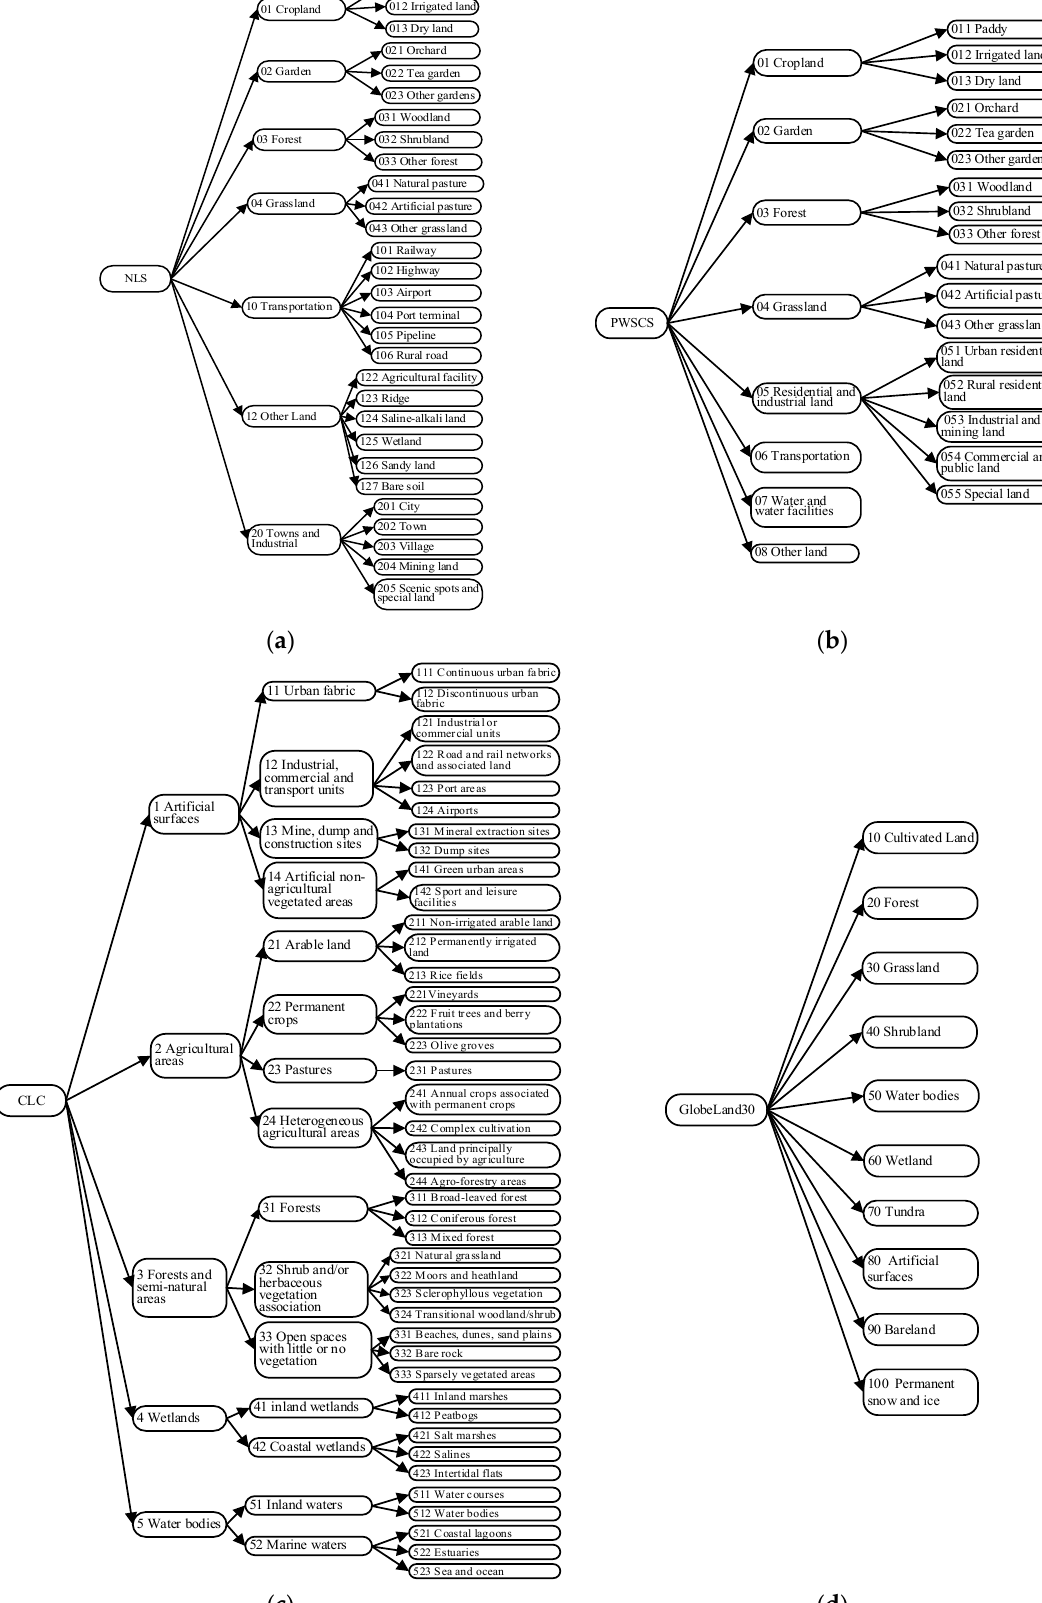
Figure 1. Classification systems in the experimental datasets: ( a ) National Land Survey (NLS); ( b ) Provincial Water and Soil Conservation Survey (PWSCS); ( c ) Corine Land Cover (CLC); ( d ) GlobeLand30.